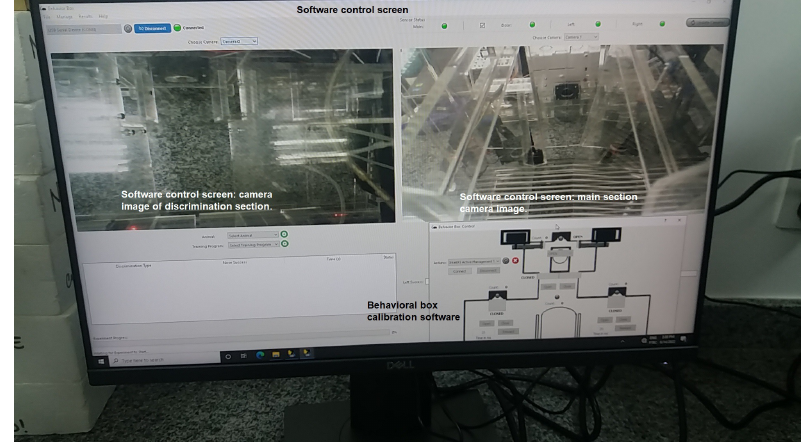
Figure 18. Behavioral box: software—final